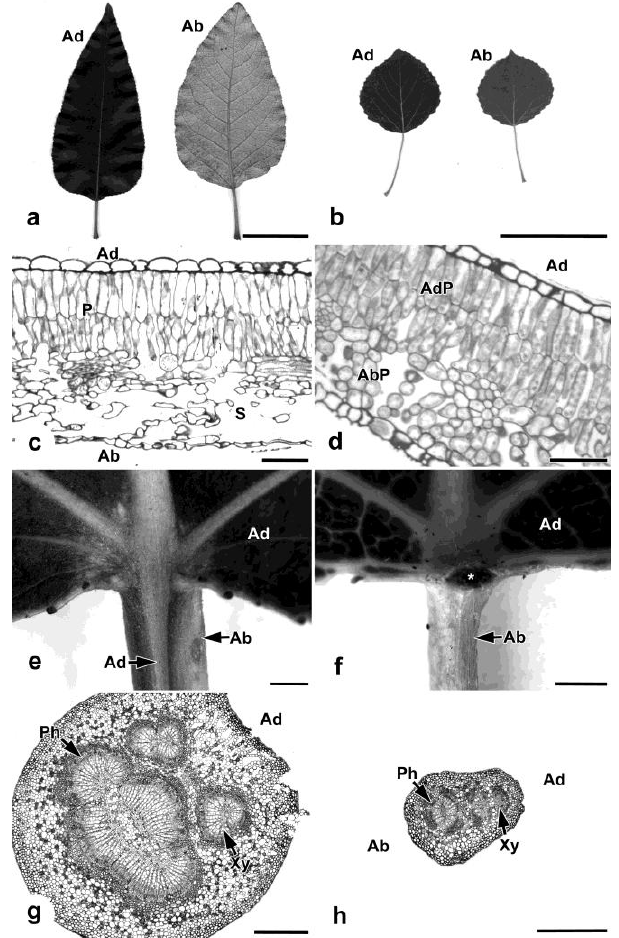
Figure 2. Black cottonwood ( a , c , e , g ) and aspen ( b , d , f , h ) leaf morphology and anatomy. ( a ) Black cottonwood leaves, showing dark green adaxial surface and lighter abaxial surface. ( b ) Aspen leaves showing similarity in coloration of both adaxial and abaxial surfaces. ( c ) Transverse section of black cottonwood leaf blade showing palisade mesophyll at the adaxial surface and spongy mesophyll at the abaxial. ( d ) Transverse section of aspen leaf blade showing adaxial palisade mesophyll at the adaxial side and abaxial palisade or palisade-like mesophyll cells at the abaxial side. ( e ) Higher magnification of the adaxial side of the petiole/blade junction in black cottonwood leaf. The adaxial surface from the leaf blade is continued in the narrow region down the petiole, while the back and majority of the petiole consists of the abaxial surface. ( f ) Higher magnification of the adaxial side of the petiole/blade junction in aspen leaf. The adaxial surface of the leaf blade does not extend down the petiole, but is instead interrupted by the gland (asterisk) located at the ―cross zone‖. The petiole, therefore, consists mostly of the abaxial surface. ( g ) Transverse section of black cottonwood petiole with the adaxial surface labeled. The petiole contains three amphicribral vascular bundles. ( h ) Transverse section of aspen petiole with the adaxial and abaxial sides, labeled in relation to the shoot. There are two amphicribral vascular bundles within the petiole. Ad: adaxial surface, Ab: abaxial surface, P: palisade mesophyll, S: spongy mesophyll, AdP: adaxial palisade mesophyll, AbP: abaxial palisade mesophyll, Ph: phloem, Xy: xylem. Scale bars = 1 cm ( a , b ), 50 µm ( c , d ), 1 mm ( e , f ), 500 µm ( g , h